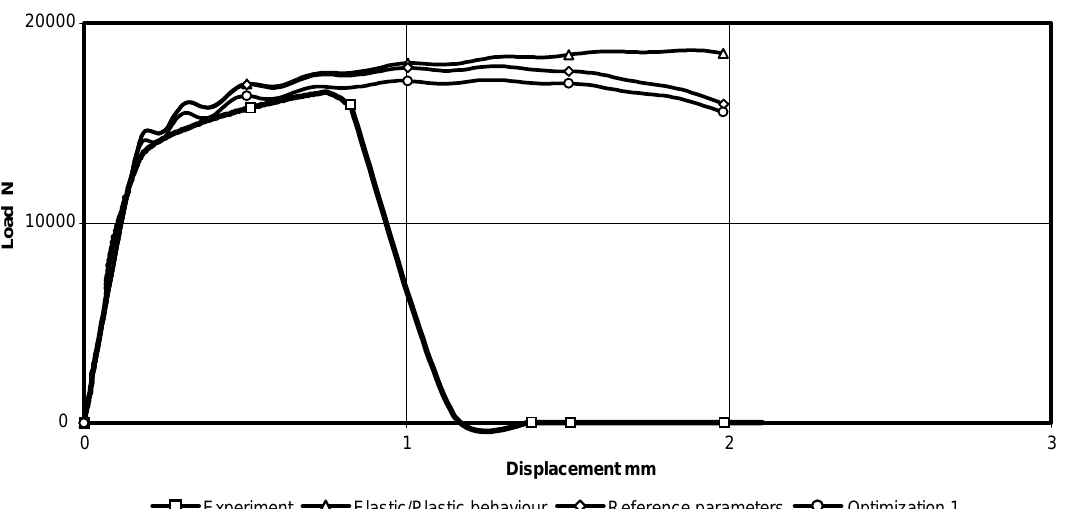
Fig. 8. Comparison of experimental and numerical results – First optimization – (Punched tension specimens – 2024-T351 aluminium alloy).